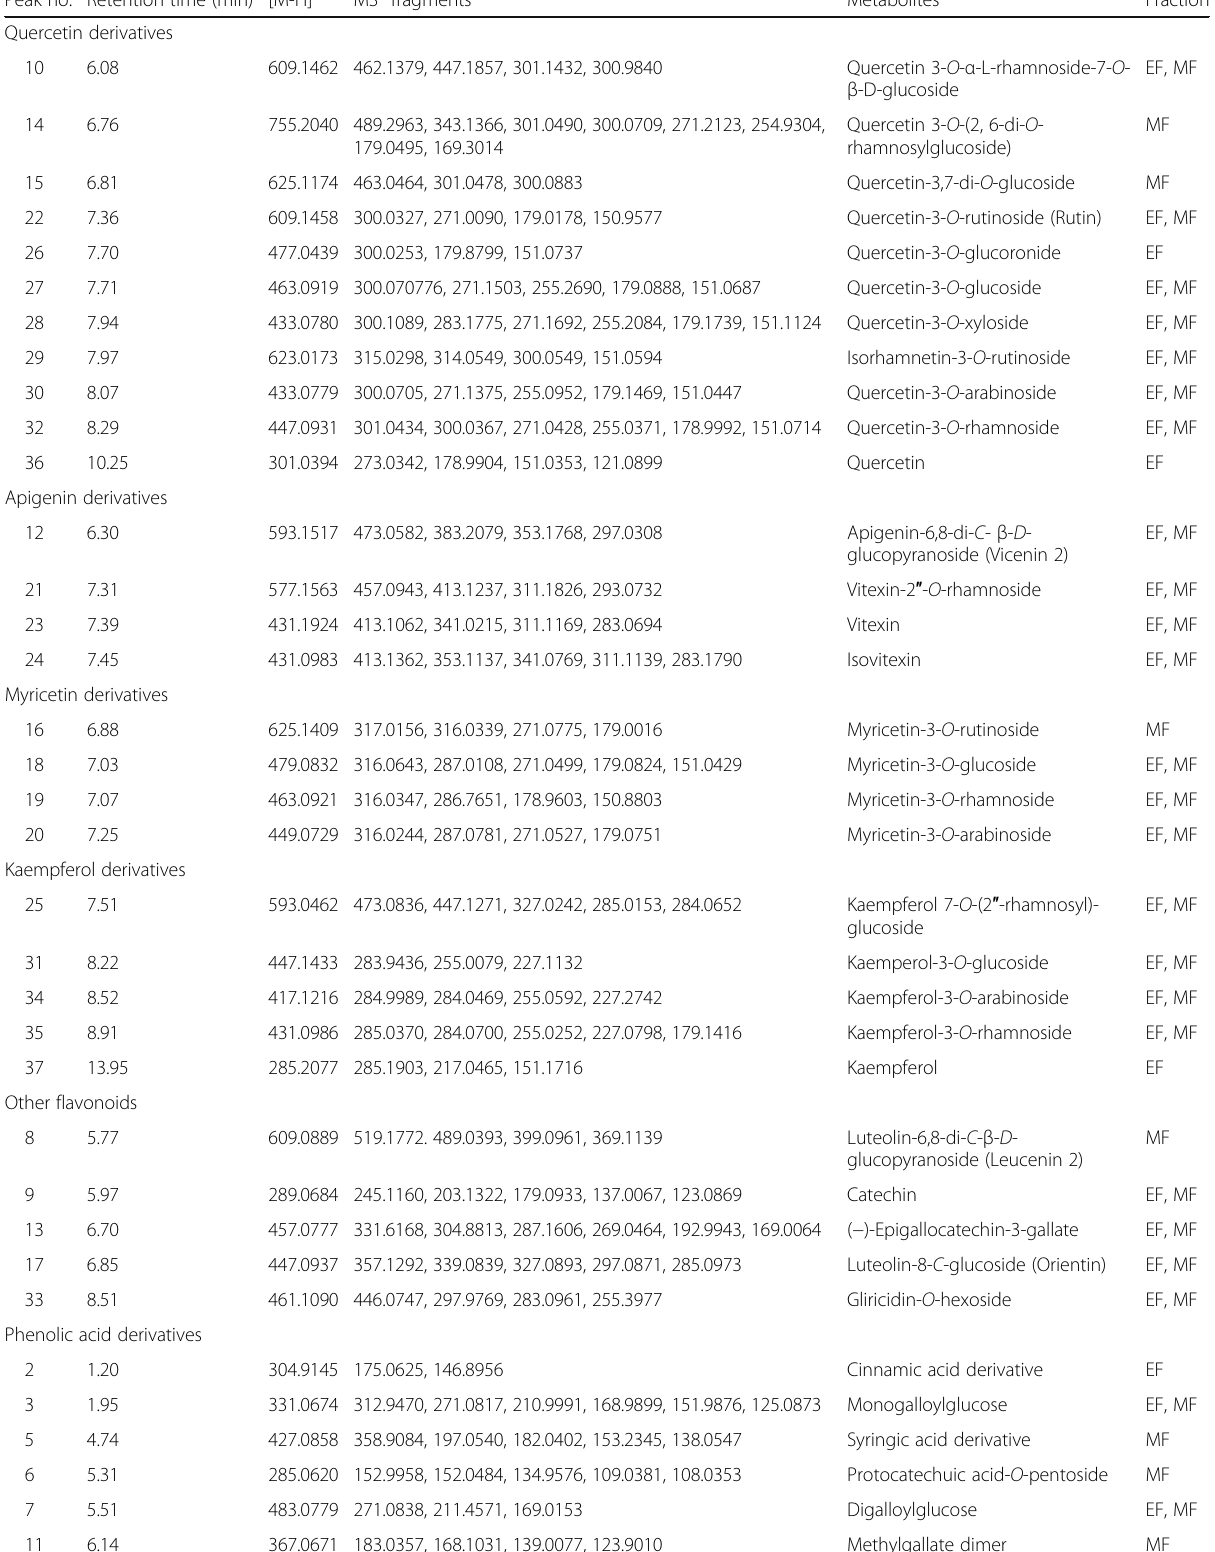
Table 2 Identification of phenolic constituents in bioactive fractions of N. oleracea based on UHPLC – MS/MS data Peak no. Retention time (min) [M-H]